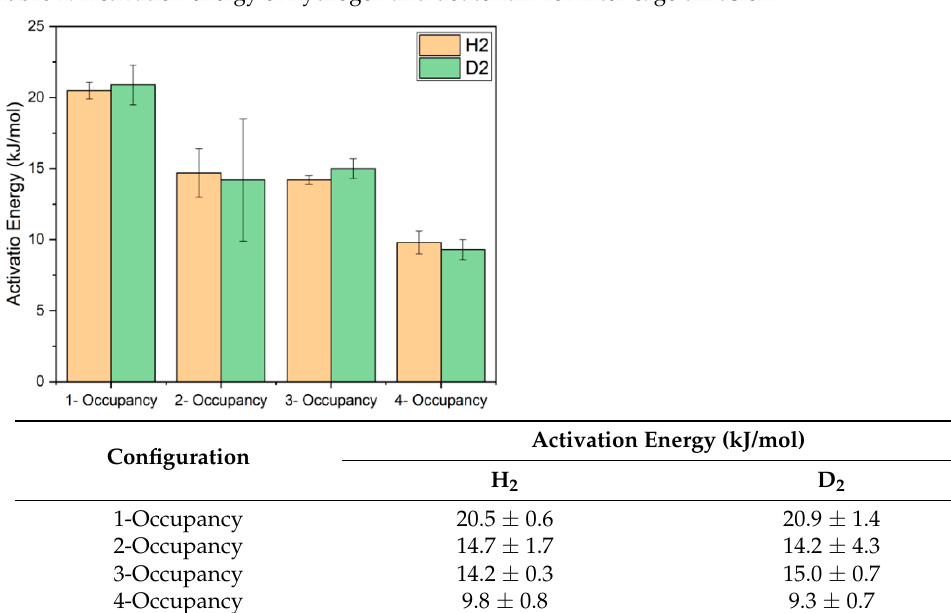
Table 1. Activation energy of hydrogen and deuterium for inter-cage diffusion.